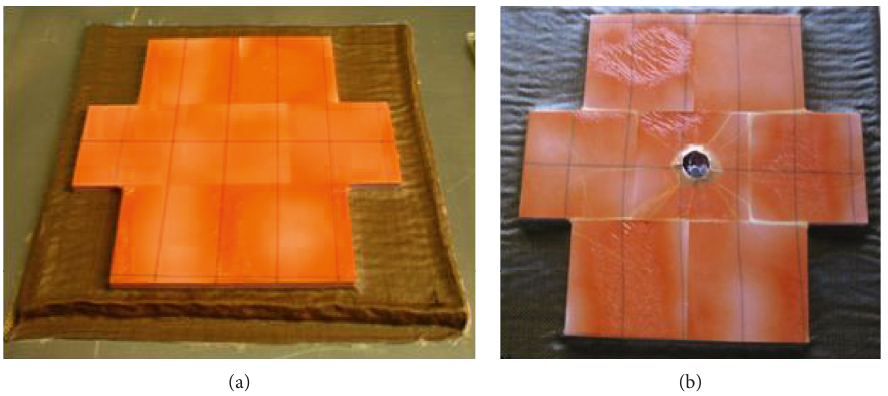
Figure 11: Ceramic and textile composite target made with 3D warp interlock fabric before impact (a) and after impact (b) with 12.7mm AP at 610m/s according to standard MIL-PRF-46103E type III